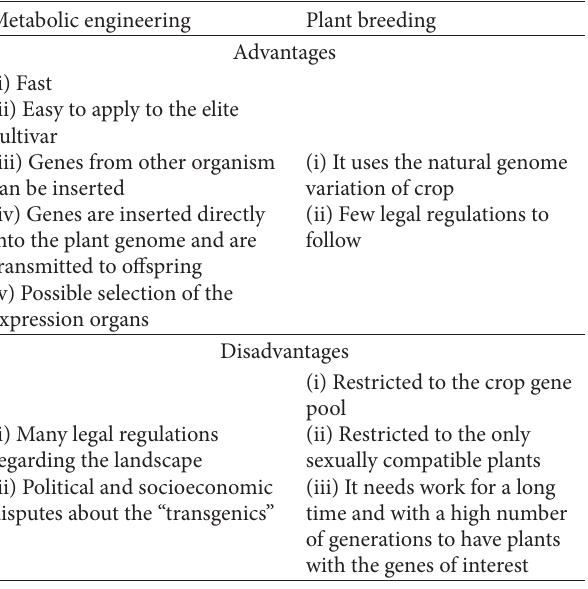
Table 4: Advantages and disadvantages of metabolic engineering and plant